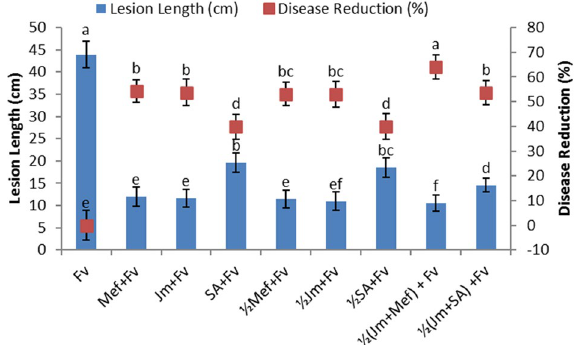
Figure 2. Effect of seed treatments with J. mimosifolia extract and control formulations on stem lesion length and disease reduction in maize inoculated with F. verticillioides (21 days after inoculation) in field experiments. Data are expressed as mean ± standard deviation (SD) of three replicates. Mean values with different letters are significantly different from each other according to the least significant difference ( LSD ) test at P < 0.05. See Table 1 for abbreviations.